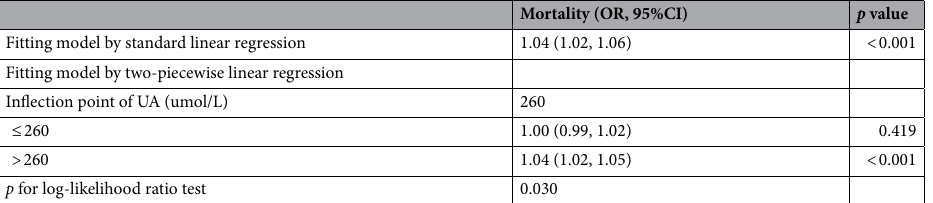
Table 4. The results of the two-piecewise linear model (UA per 10 increments). Adjusted: age, gender, BMI, smoking, hypertension, diabetes, Marfan syndrome, Bicuspid aortic valve, CRI, stroke, atherosclerosis, time to presentation, SBP, DBP, aortic diameter, aortic regurgitation, abdominal vessel involvement, arch vessel involvement, EF value, Cr, BUN, TG, TC, HDL, LDL, symptom, coronary malperfusion, mesenteric malperfusion, cerebral malperfusion, hypotension/shock, cardiac tamponade and operation. BMI body mass index, SBP systolic blood pressure, DBP diastole blood pressure, Cr creatinine, BUN blood urea nitrogen, eGFR estimated glomerular filtration rate, UA uric acid, TG triglyceride, TC total cholesterol, HDL high-density lipoprotein, LDL low-density lipoprotein, FDP fibrinogen and fibrin degradation products, CRP C-reactive protein, CRI chronic renal insufficiency, EF ejection